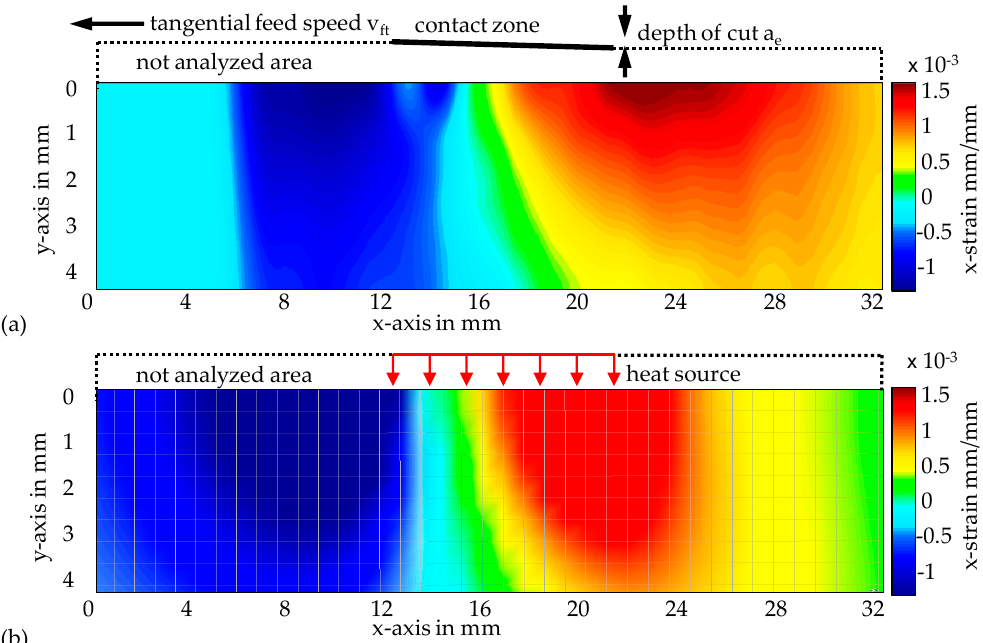
Figure 8. Total strain during the process in feed speed direction: ( a ) calculated from the speckle photography measurements; ( b ) simulated.